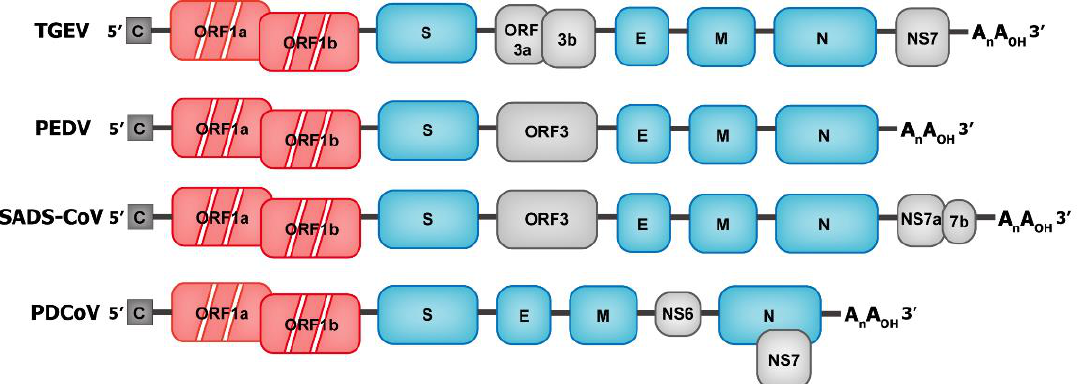
Figure 2. Genome structure of swine enteric coronaviruses (SeCoVs). The genomic structures of the four known SeCoVs are shown in the schematic diagram above (not to scale). The 5 ′ -cap structure and 3 ′ polyadenylation are 5 ′ -C and AnAOH-3 ′ , respectively. Following the open reading frame ORF1ab (marked in red) are genes encoding structural and accessory proteins. Structural proteins (S, E, M, and N) are marked in blue and accessory proteins are marked in gray.